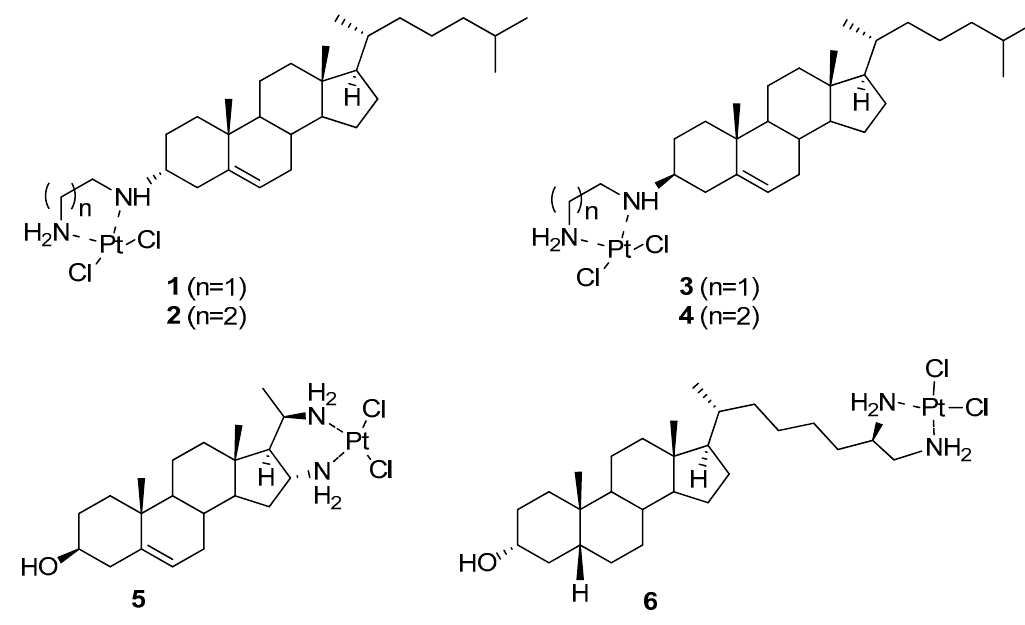
Figure 2. Steroid-based cisplatin derivatives [6,7].